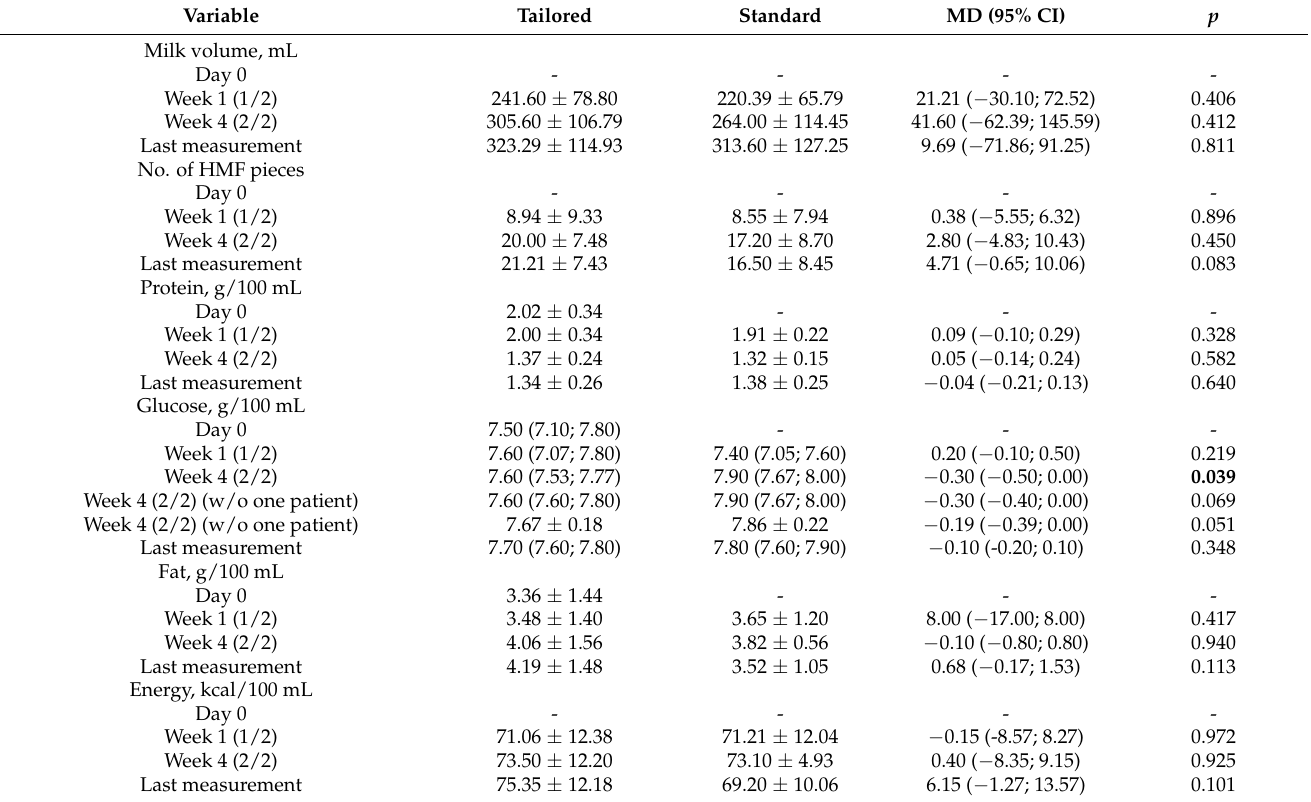
Table 2. Milk composition during supplementation